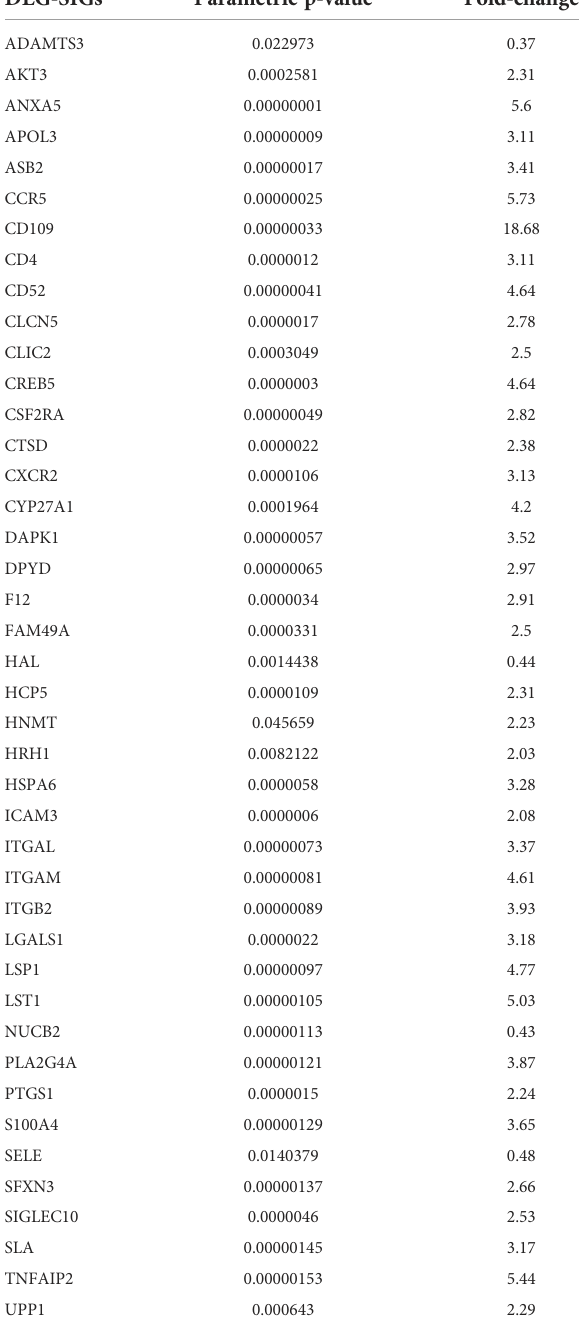
TABLE 1 Common 42 intersecting genes of differentially expressed genes (DEGs) and survival-related immune genes (SIGs) between immune in fi ltration-lacking subtype (IL type) and immune in fi ltration- rich subtype (IR type) (P < 0.05, | Fold Change |>2 or